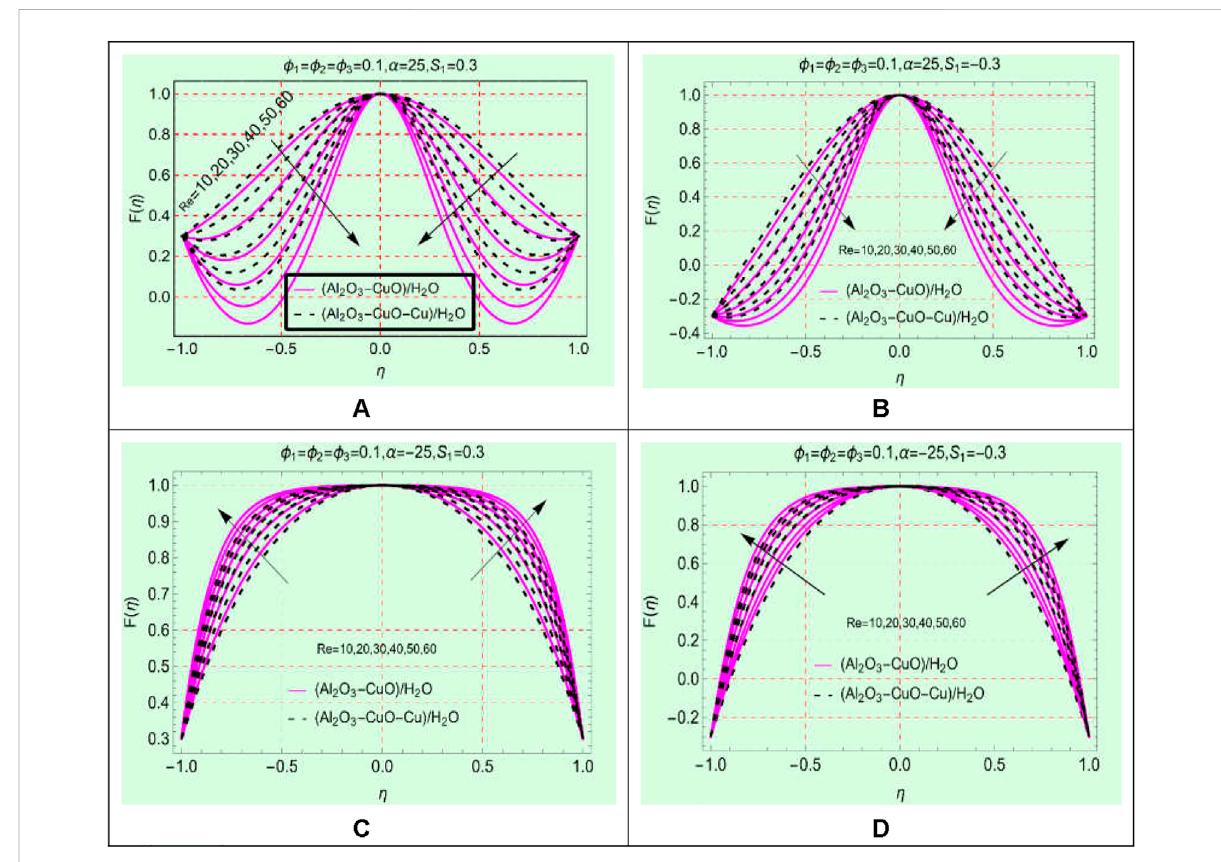
FIGURE 5 F ( η ) against Re (A) stretching and divergent, (B) shrinking and divergent, (C) stretching and convergent, and (D) shrinking and